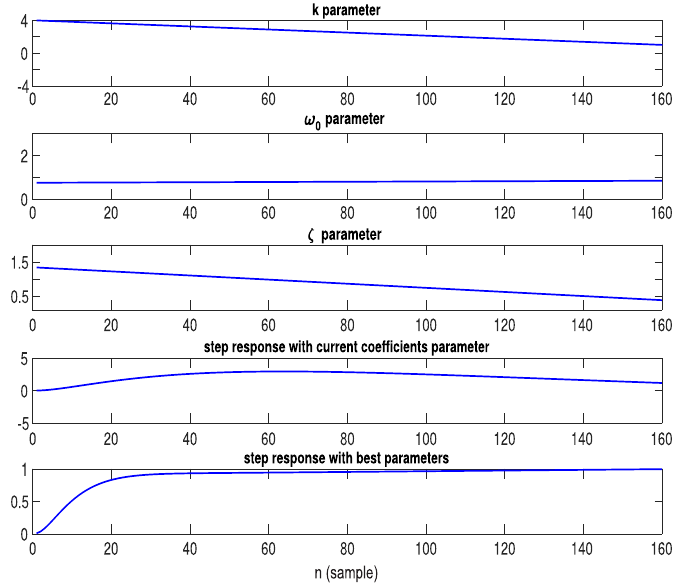
Figure 9. First stage of the optimization routine. Exemplary middle-stage of the iterative optimization